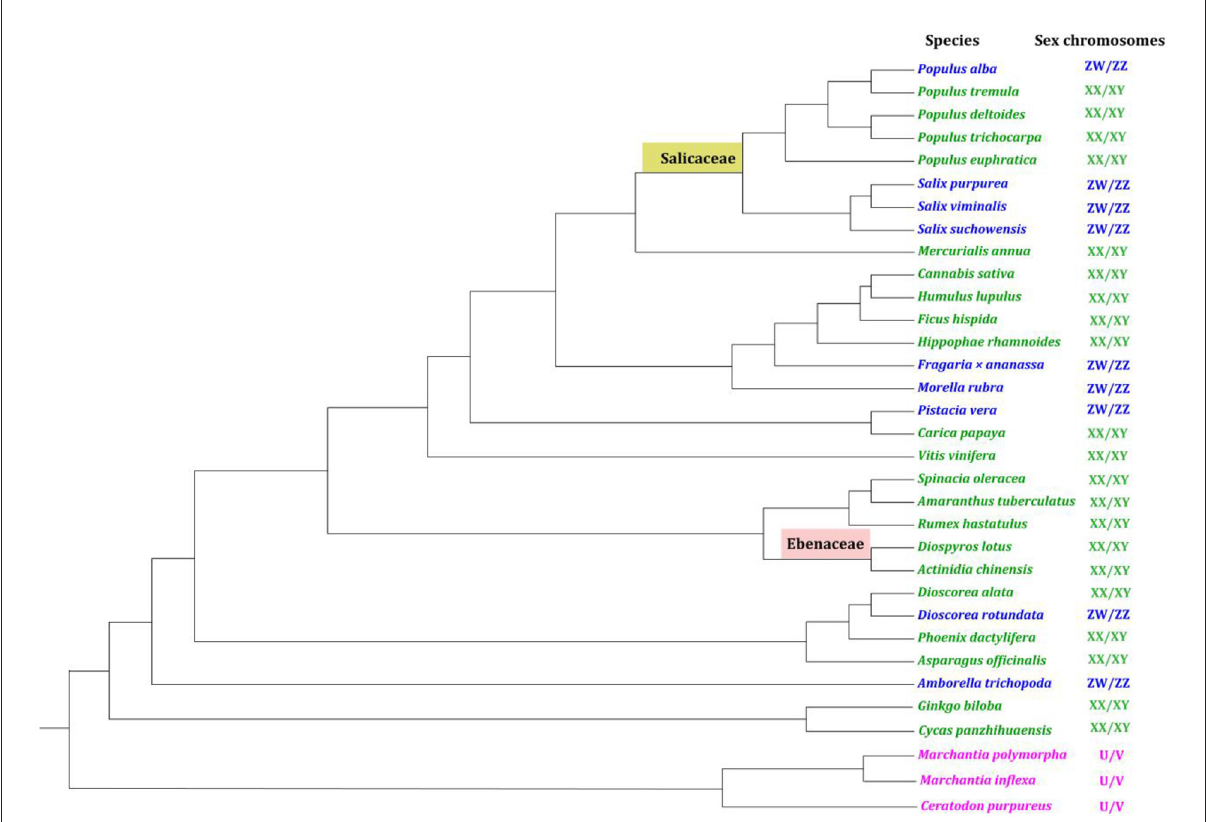
FIGURE2 Dioecious plants with reference genomes and convinced sexual systems in a phylogenetic perspective. The male heterogametic system (XY/XX), female heterogametic system (ZW/ZZ), and haploid sex system (U/V) are shown in green, blue, and pink respectively. The distantly-related lineages of poplar (Salicaceae) and persimmon (Ebenaceae) are respectively highlighted in yellow and light red. The phylogenetic tree was reconstructed using chloroplast genome sequences via the online RAxML method in CIPRES (http://www.phylo.org/) (Supplementary Table